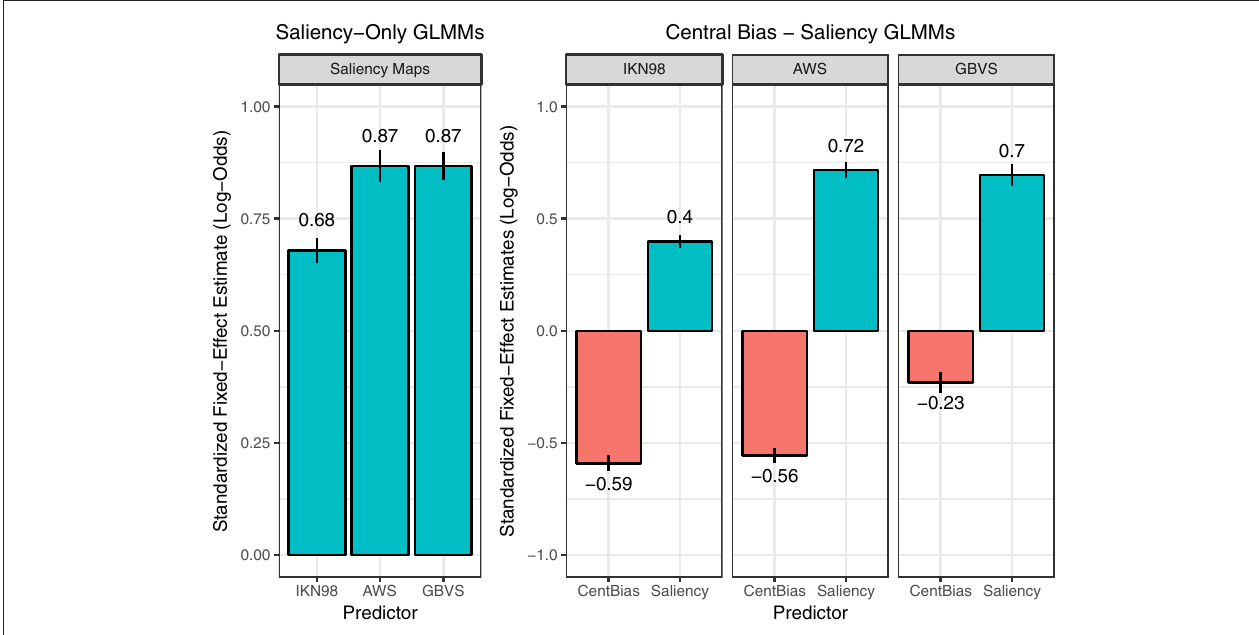
FIGURE 3 | Saliency-only GLMMs (left) and Central-Bias—Saliency GLMMs (right). The figure visualizes the fixed-effect estimates and standard errors for standardized regression coefficients (i.e., slopes). The data in the left panel are from three saliency-only GLMMs that each tested a different saliency model (IKN98, AWS, GBVS). Here, a larger fixed-effects estimate for the slope corresponds to a greater effect of image saliency on fixation probability. The data on the right are from three Central-Bias—Saliency GLMMs, one for each saliency model. These GLMMs test whether image saliency has an independent effect above and beyond what can be accounted for by central bias. Each GLMM included the anisotropic Euclidean central-bias predictor, along with the intercept and the saliency predictor. Each panel in the facet plot presents the data for one saliency model. Specifically, each bar graph depicts fixed-effect estimates for standardized regression slopes for central bias (left bar) and saliency (right bar). A more negative central-bias coefficient is indicative of a stronger central bias.